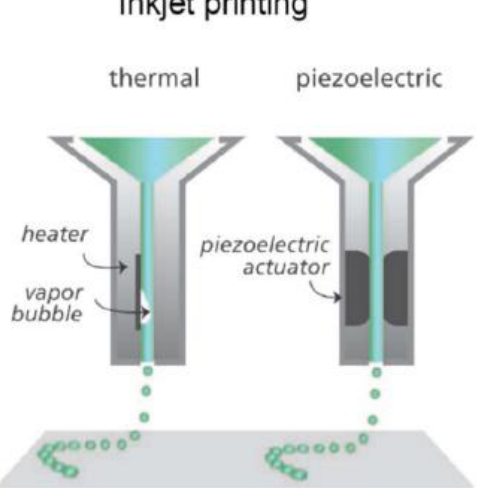
Figure 5. Two of the most common inkjet nozzles used for 3D printing (reprinted with permission from Malda et al.; copyright (2013) [86]). Thermal printing vaporizes small volumes of the ink to generate the necessary pulse to expel the droplets [86]. The piezoelectric method uses a direct mechanical pulse to generate a shockwave to expel the droplets [86].